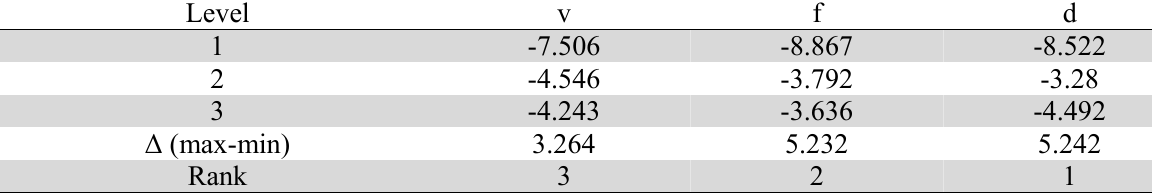
Response table of mean S/N ratio for chip reduction coefficient